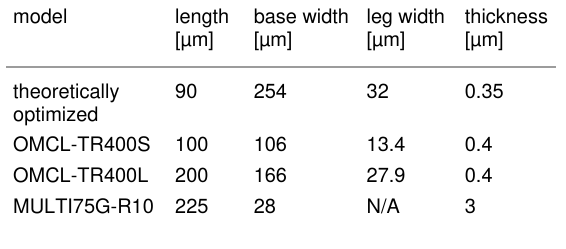
Table 6: Geometrical specifications provided by